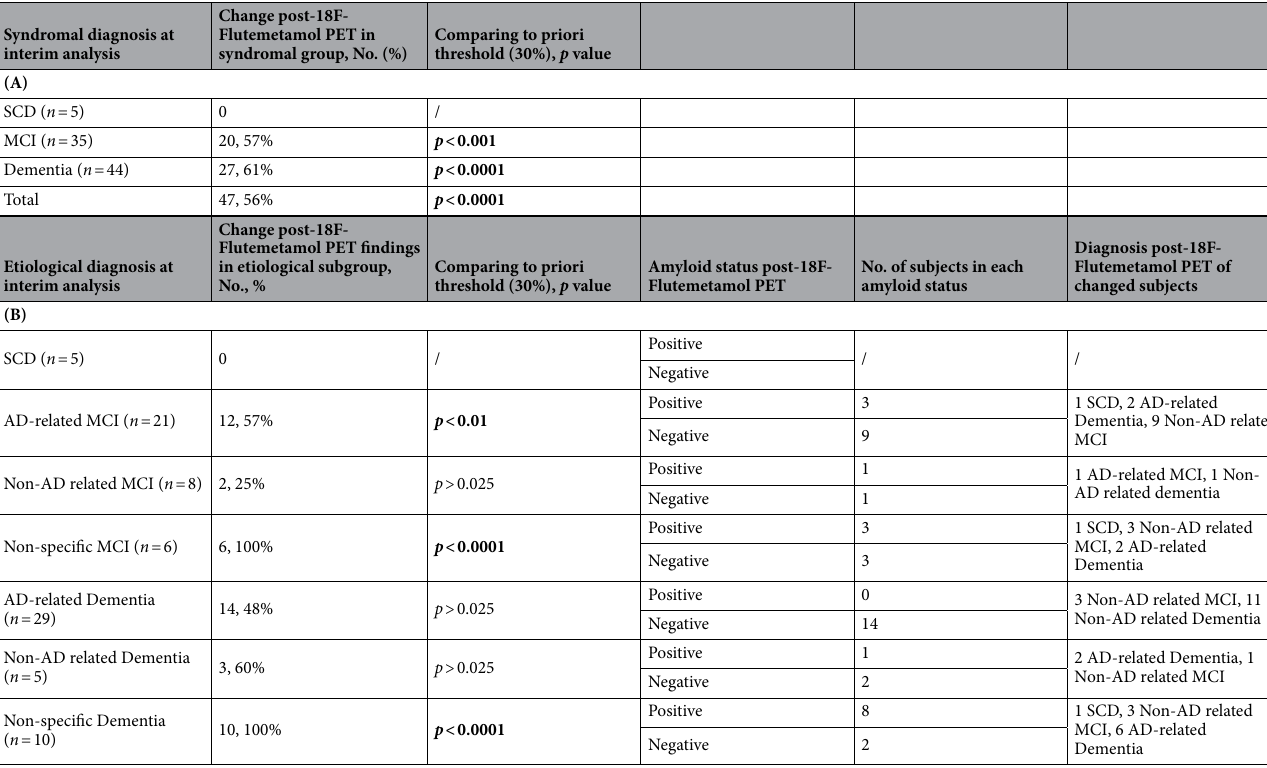
Table 6. Change in diagnosis following 18F-Flutemetamol PET. (A) in the syndromal group, (B) in the etiological subgroup. Significant values are in